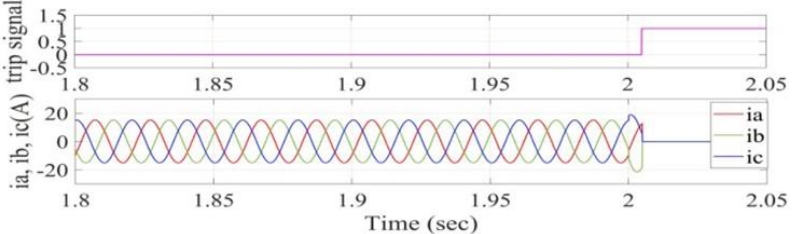
Figure 28. Stator current signals and the trip signal waveforms for 50% stator fault in phase (c) on a no-load condition.